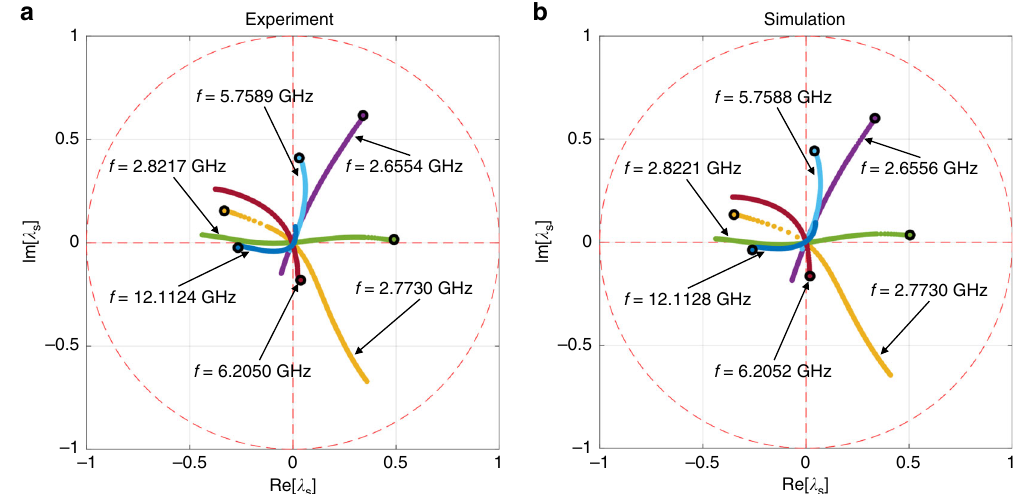
Fig. 2 Plot of selected S -matrix eigenvalues as a function of attenuator setting in the tetrahedral graph showing examples of near-zero-crossing trajectories. Selected eigenvalues of the S -matrix are plotted in the complex λ S plane, where the red dashed circle represents the unit circle. a Shows experimental data, while b shows data from the simulation. Each trajectory represents one frequency (color coded), and the corresponding frequency for each trace is labeled in the fi gure. The black circle at the start of every trajectory indicates the initial eigenvalue at minimum attenuation, and as attenuation increases, the eigenvalue goes nearly through the origin in the complex